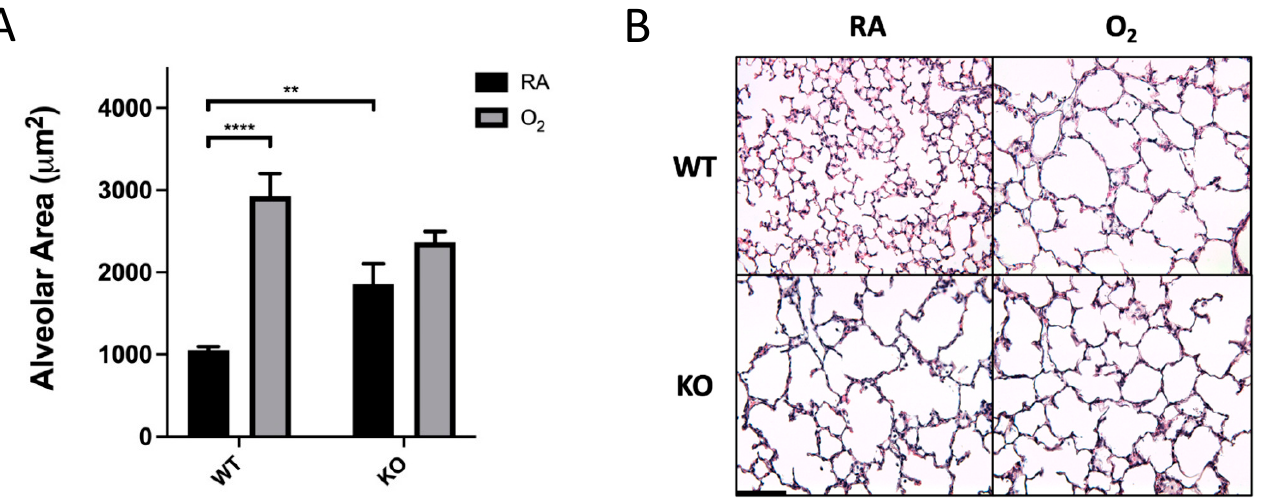
Figure 1. Hyperoxia exposure and SOD3 KO alone induced alveolar simplification, but there was no additive effect of genotype and exposure. ( A ) WT and KO mice were exposed to 14 days of either 75% O 2 or RA prior to analysis. Lungs were sectioned, H&E-stained, and analyzed at 20 × magnification. Alveolar area was significantly higher in O 2 -exposed mice in the WT genotype but not the KO genotype. Data are presented as ± means SEM; ** p < 0.01, **** p < 0.0001; n = 8–15 per group. ( B ) Representative (20 × ) images of H&E-stained P14 mouse lung. Scale bar is 100 µ m.